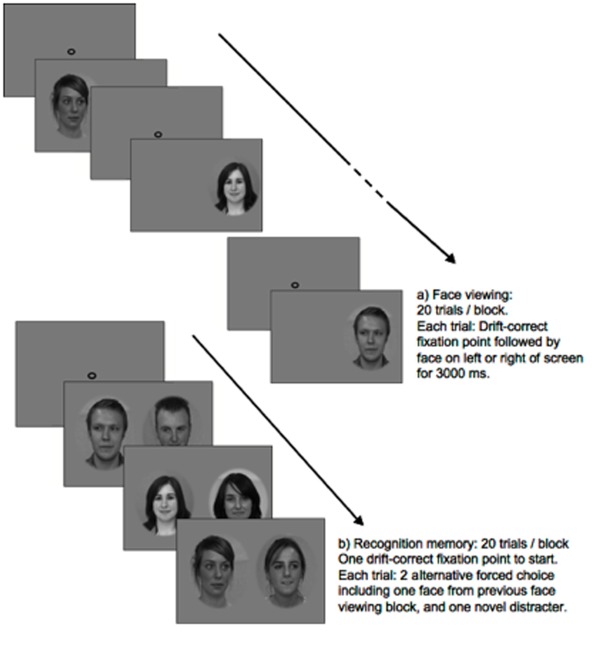
Trial sequence for recognition memory test (direct eye gaze condition).(a) Face viewing, 20 trials/block; (b) 2-alternative forced-choice recognition memory test, 20 trials/block.